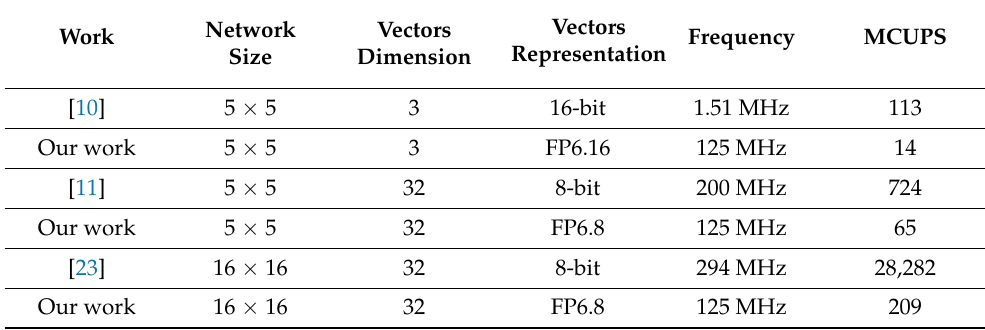
Table 5. Performance